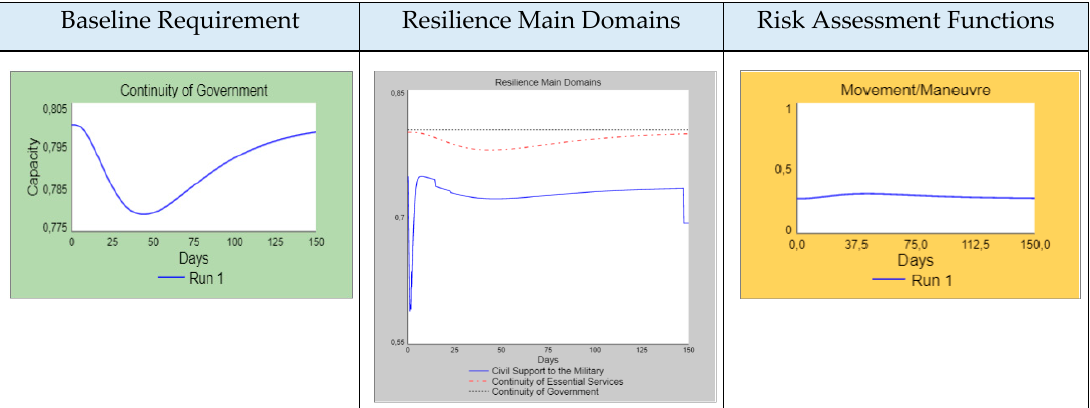
Figure 6. Sample graphs from output dashboard.